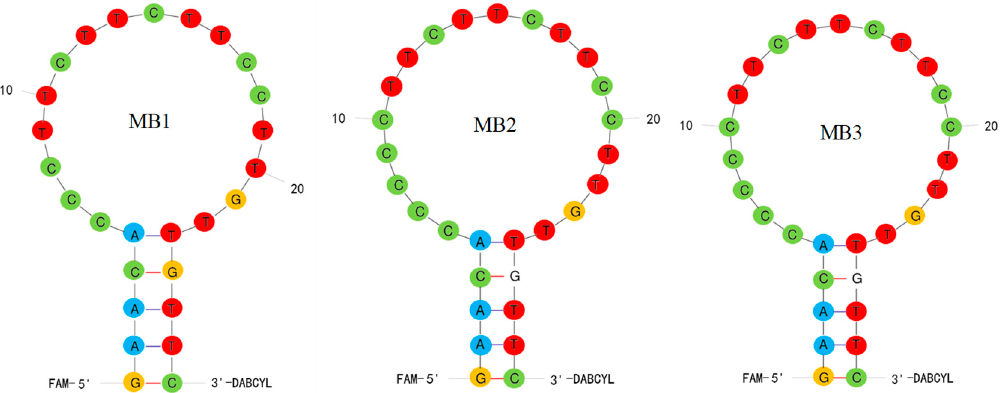
Figure 2. Secondary structures of three molecular beacon aptamers.